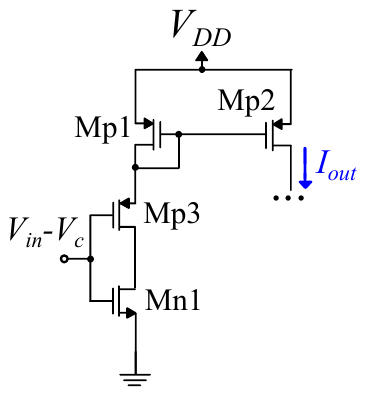
Figure 33. Gaussian function circuit with voltage correlator.